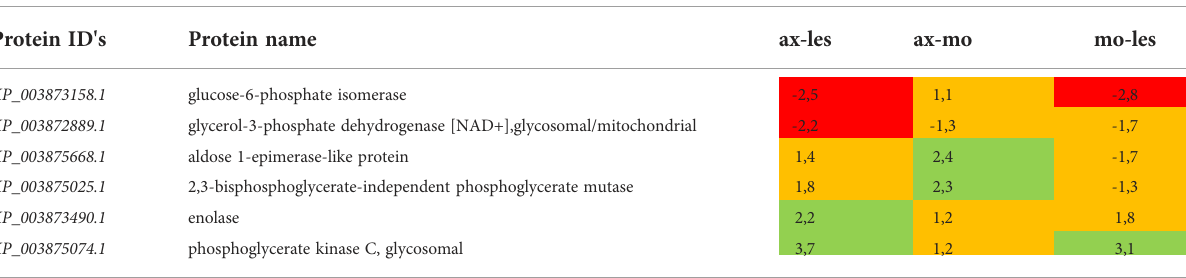
TABLE 2 Glycolytic proteins identi fi ed in all 3 comparisons that differ by at least 2-fold (T-test signi fi cant) between individual amastigote types.